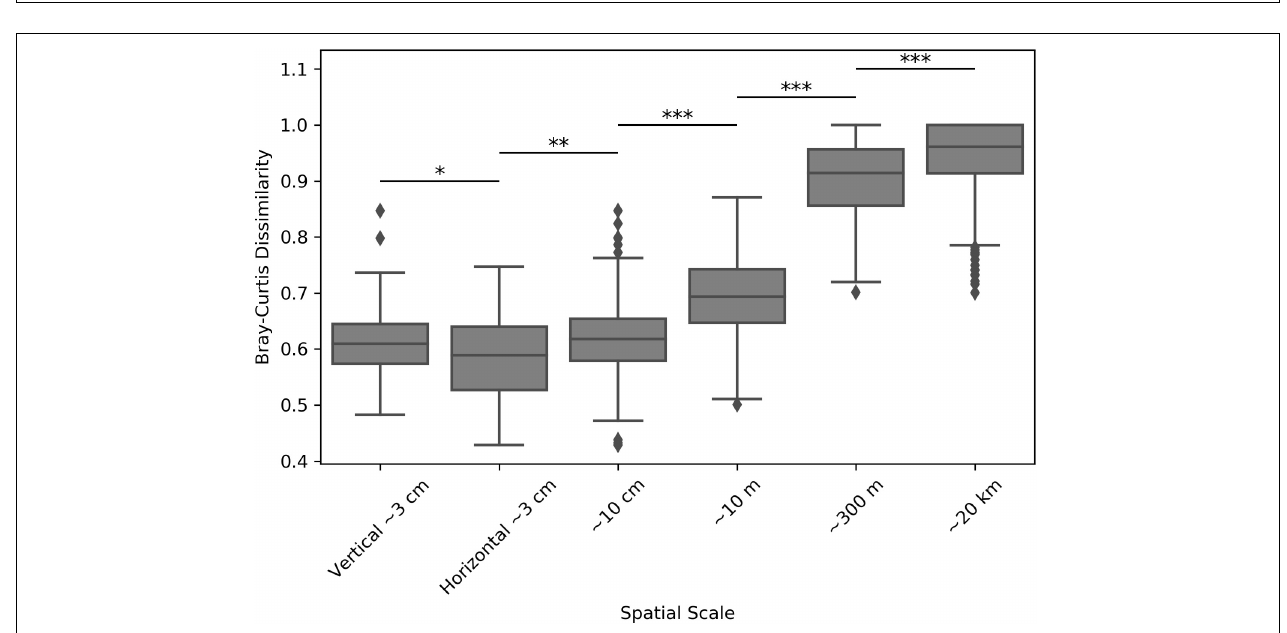
FIGURE 5 | Relative abundance of major halite microbiome phyla inside the halite nodules at the top, middle, and bottom positions within each sampled nodule slice. The relative abundances were standardized to the average abundance of that phylum in each slice. Chlorophyta (chloroplast) sequences were only detected at low abundances is a few samples, and are not shown here. Bars above each phylum represent Student’s t -test significance, and the stars denote the associated p -value (*** p < 0.0001, ** p < 0.001, * p < 0.01).